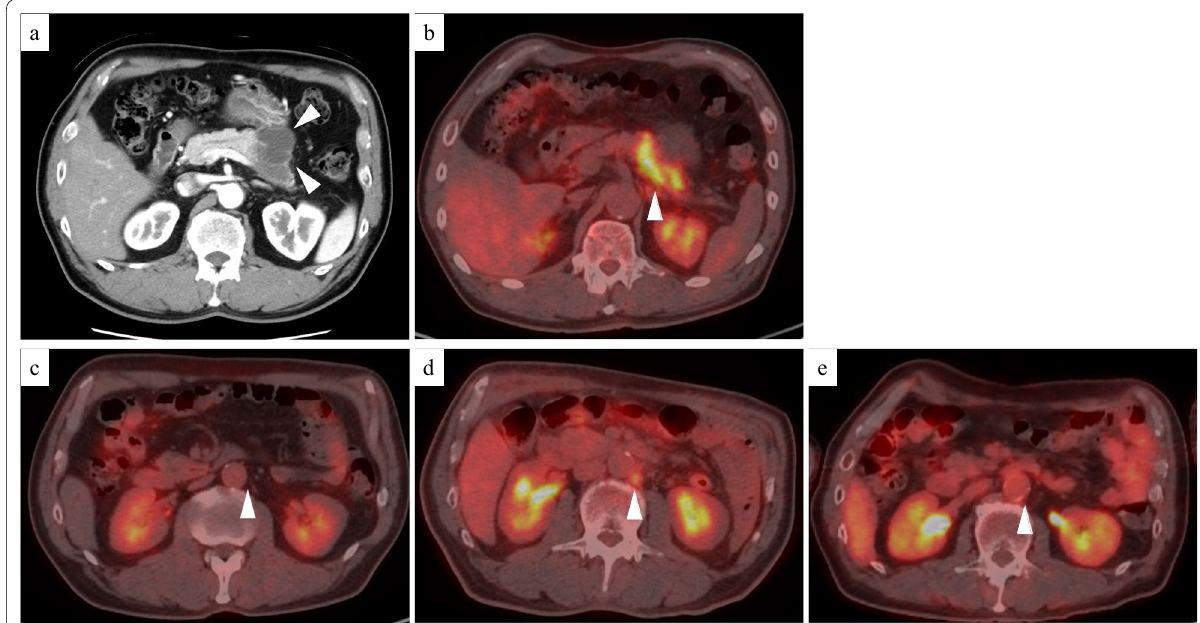
Fig. 1 Enhanced computed tomography (CT) and fluorodeoxyglucose-positron emission tomography (FDG-PET)/CT. a Enhanced CT horizontal image (arterial phase) shows a pancreatic tail tumor with cystic lesion 46 mm in diameter (arrowhead). b FDG-PET/CT image taken before the first surgery: FDG accumulation with a standardized uptake value (SUV)max of 7.1 is observed in the pancreatic tail tumor. c FDG-PET/CT image taken before the first surgery: FDG accumulation is not observed in the para-aortic lymph node. d FDG-PET/CT image taken before revised chemotherapy regimen: FDG accumulation with a SUVmax of 3.0 is observed in the para-aortic lymph node. e FDG-PET/CT image taken after resection of the metastatic brain tumors: FDG accumulation was not observed in the para-aortic lymph